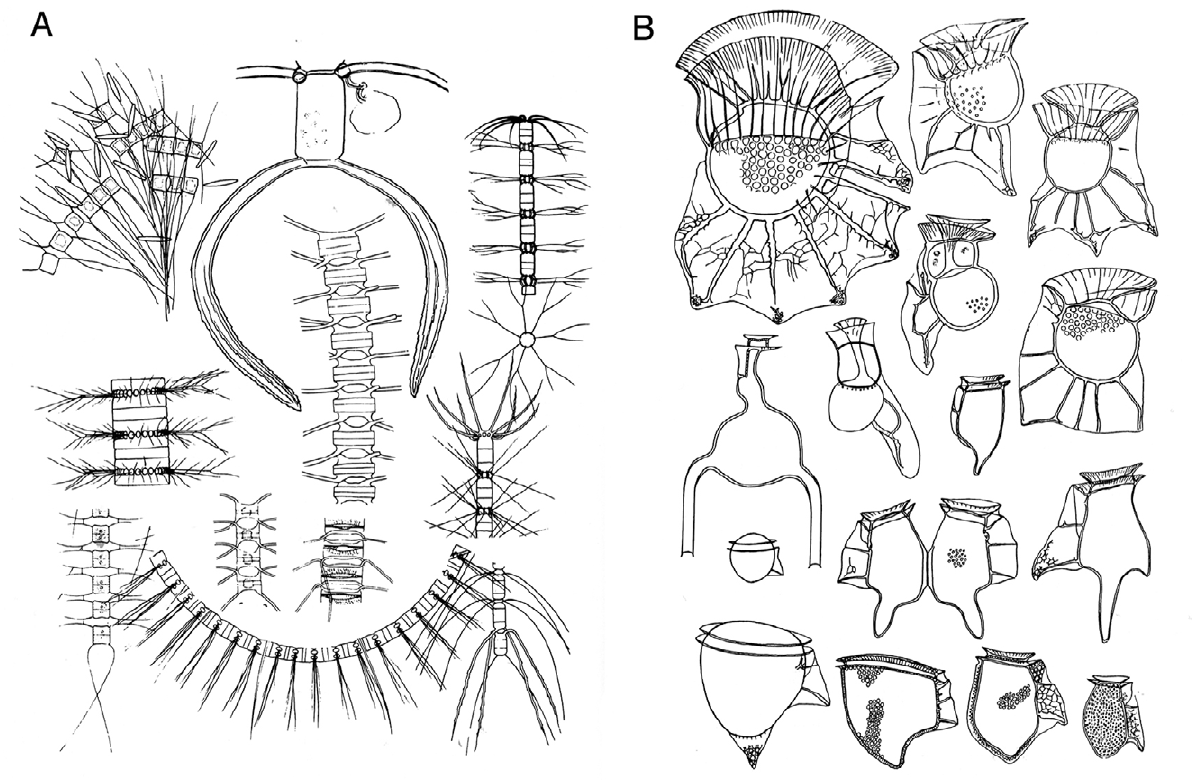
Fig. 5. – Original drawing from Ramon Margalef for Ecologia marina (Margalef 1967e, reproduced in Delgado and Fortuño 1991). Fine-line drawings. A) Diatoms. B)